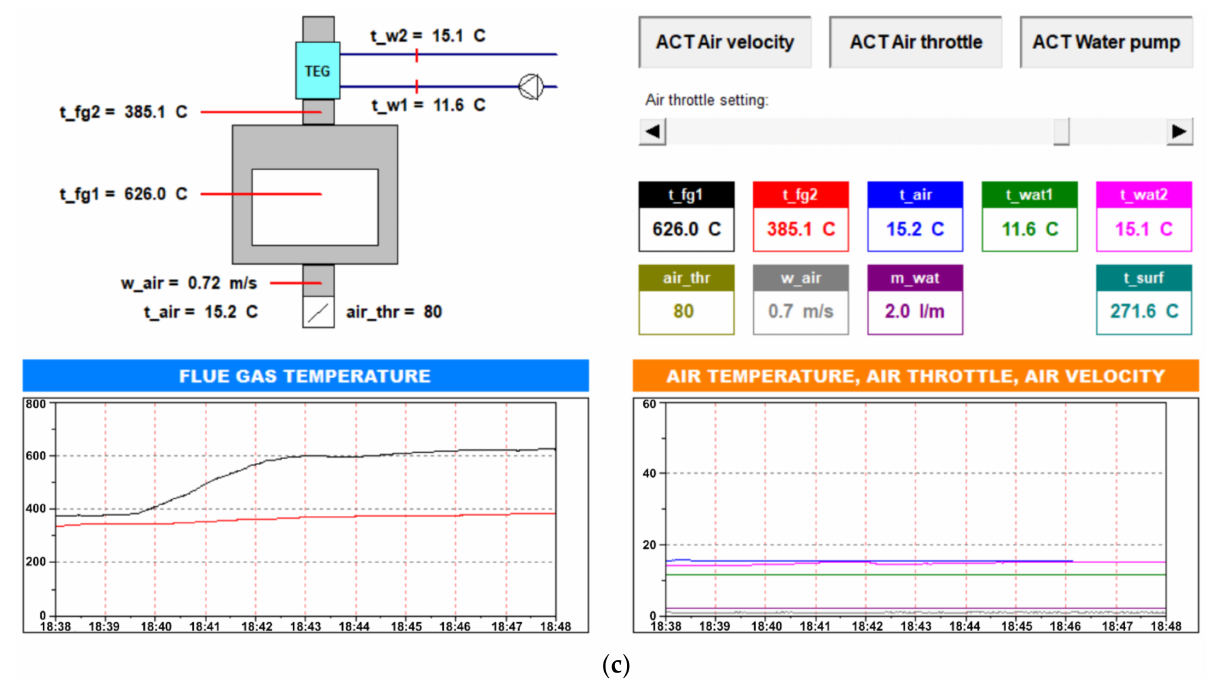
Figure 6. View of the control cabinet ( a ), electronic load ( b ), and visualization created in CoDeSys software ( c ). 2.2. The Initial Version of the Developed Thermoelectric Generator (TEG No. 4)